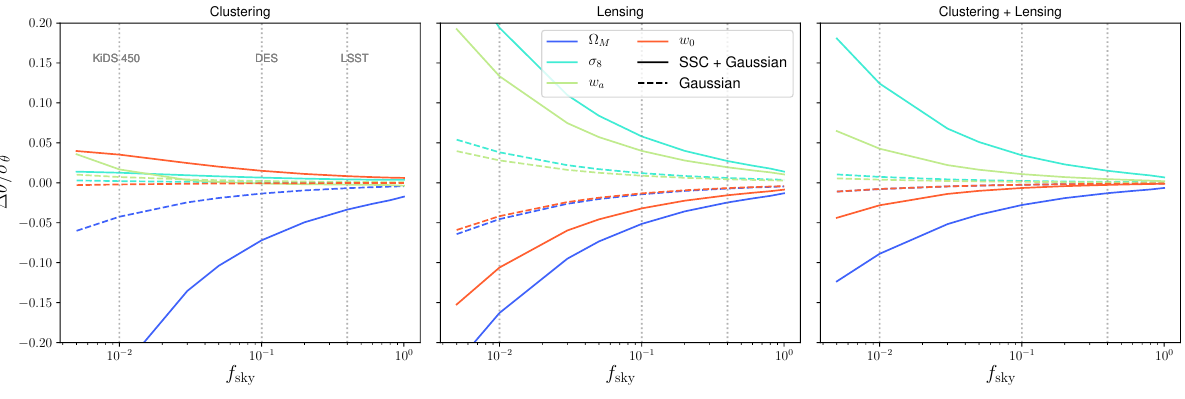
20% of the ∼ 0 . 4). (cid:39)